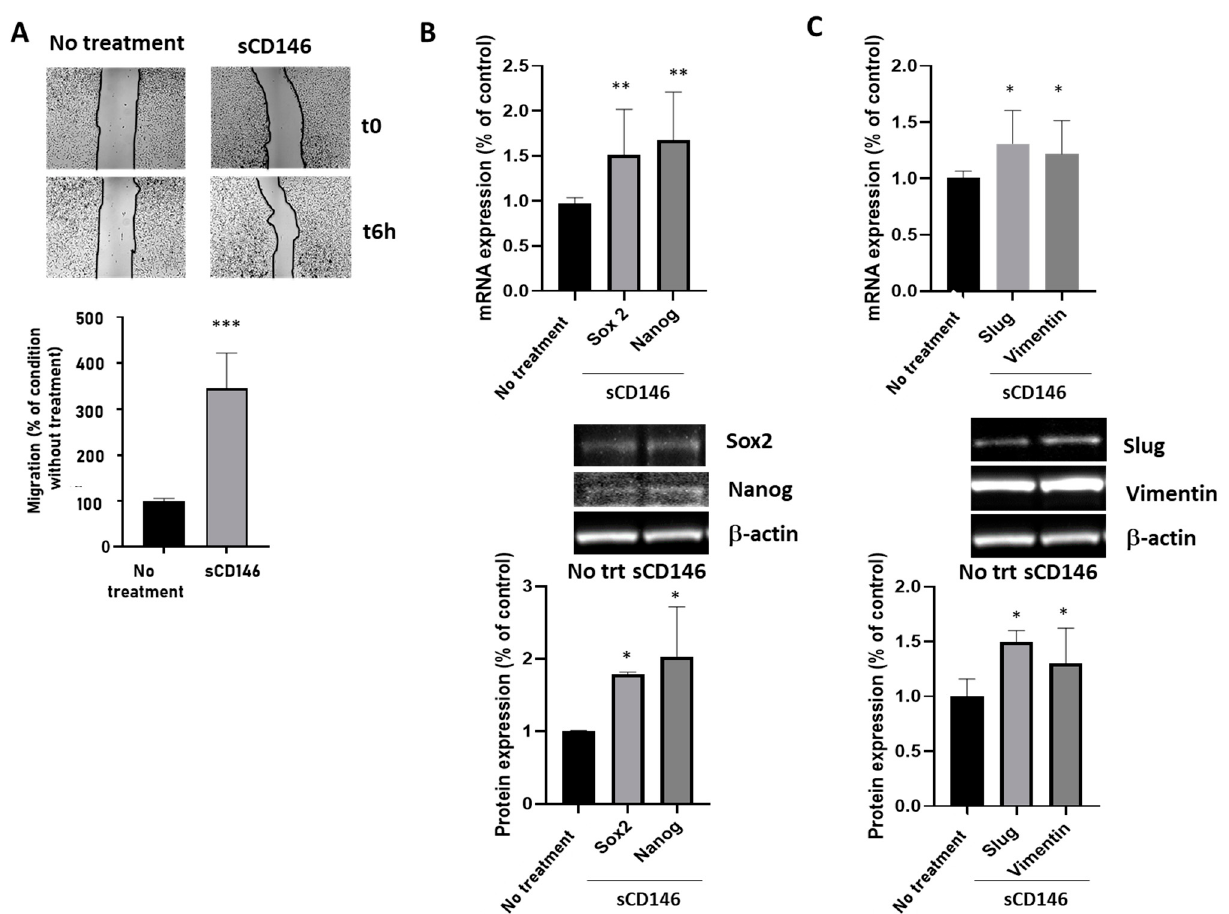
Figure 4. Effect of sCD146 in CD146 high MDA-MB-231 cells. ( A ) Effect of sCD146 100 ng/mL for 6 h on migration rates in high-CD146 MDA-MB-231 cells compared to the absence of treatment. Images show representative pictures of the migration assay, and the average of three experiments is given. ( B ) Effect of sCD146 100 ng/mL for 24 h on the expression of the CSC markers Sox2 and Nanog at the mRNA (qPCR) and protein (Western Blot) levels compared to the absence of treatment. Representative experiments and the average of four to five experiments are given. ( C ) Effect of sCD146 100 ng/mL for 24 h on the expression of the EMT markers Slug and Vimentin at the mRNA (qPCR) and protein (Western Blot) levels compared to the absence of treatment. Representative experiments and the average of four to five experiments are given. *, **, ***: p < 0.05, p < 0.01, p < 0.001 experimental vs. no treatment (No trt).